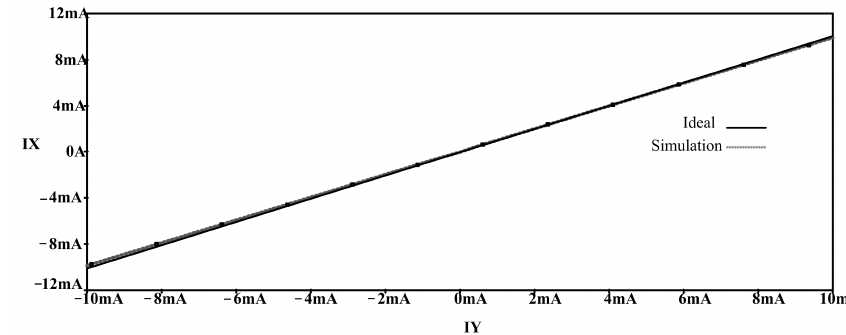
Figure 10. DC transfer characteristic between I X and I Y